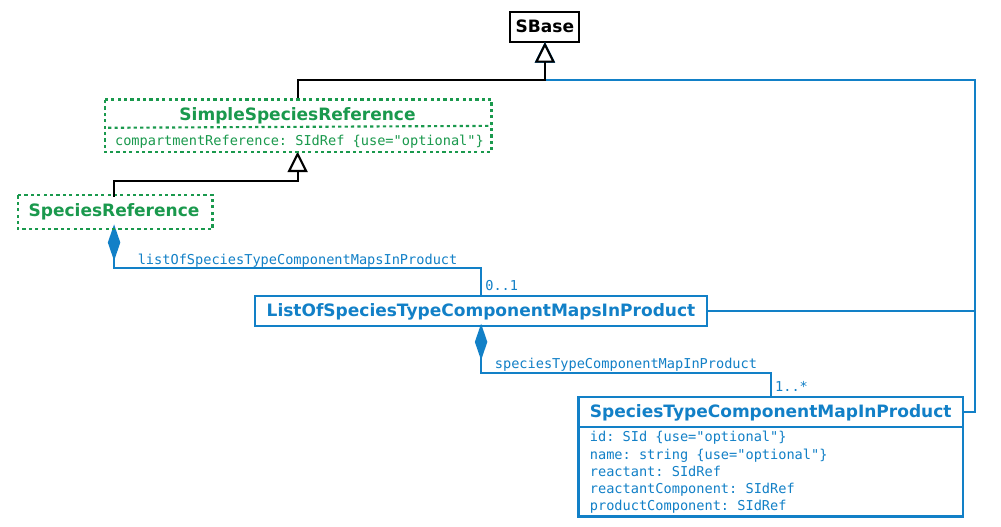
Figure 16: The extension of the SpeciesReference